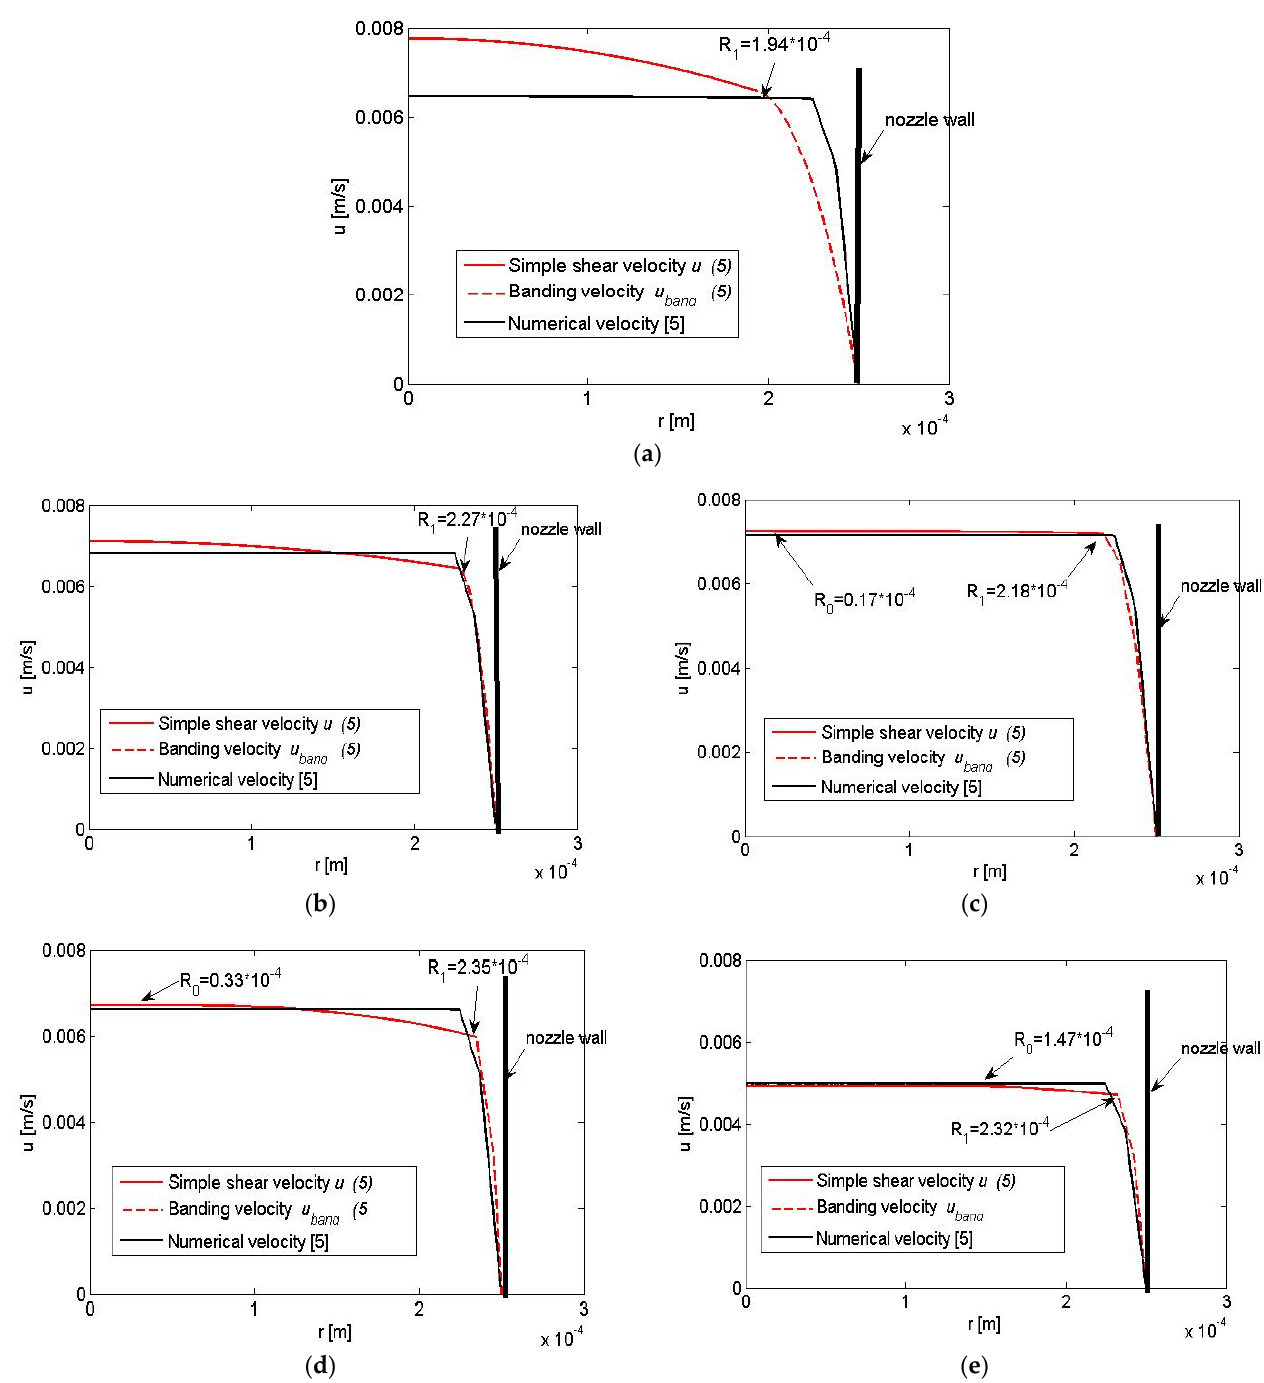
Figure 7. Comparison between the velocities’ profiles in the yield and simple shear regions (solid red line) and in the banding region (dashed red line) with the numerical velocity [5], for ( a ) PLA. ( b ) 1.5% GNP/PLA and ( c ) 9% GNP/PLA. ( d ) 1.5% MWCNT/PLA and ( e ) 9%